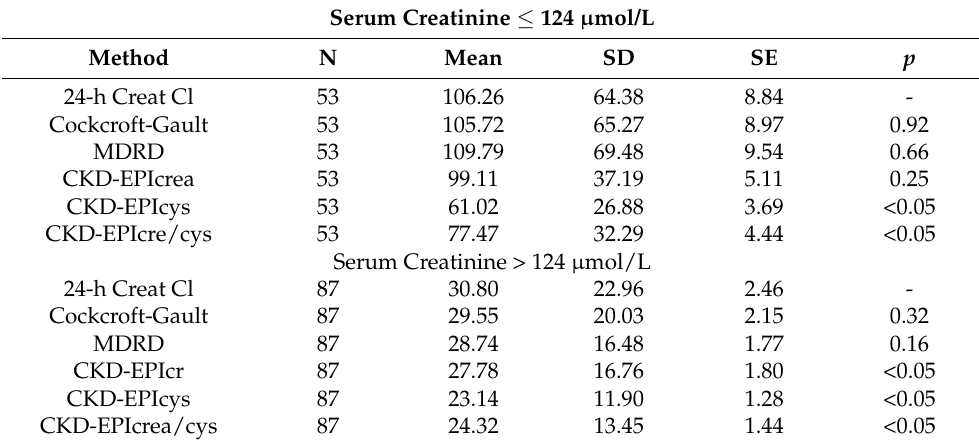
Table 4. Comparison of methods for serum creatinine ≤ 124 µ mol/L and creatinine > 124 µ mol/L.